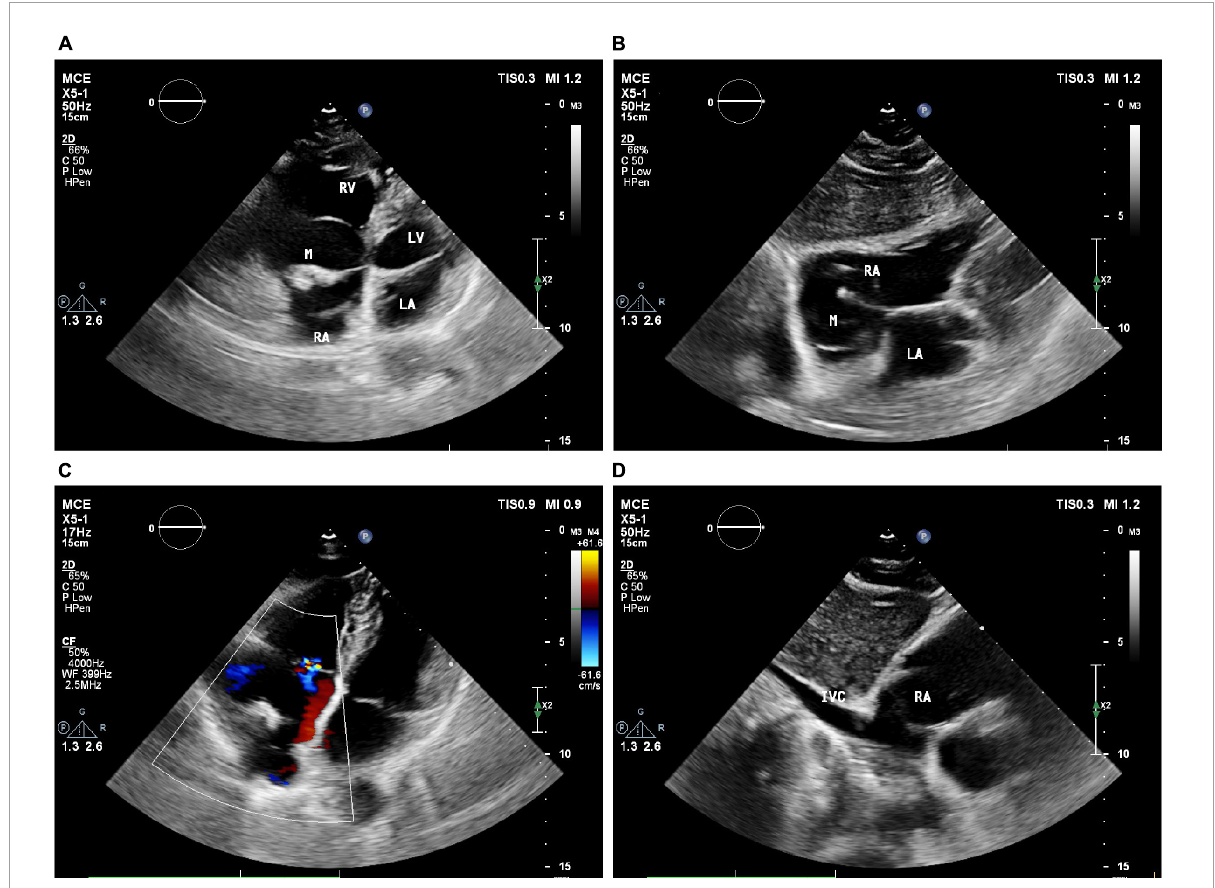
FIGURE1 Echocardiography showed a large cystic-solid mixed echogenic lesion in the right atrium. Apical four-chamberview (A) and subxiphoid four-chamber view (B) showed that the mass was attached to the right atrial surface of the atrial septum. Ultrasound findings of tricuspid valve orifice (C) andinferior vena cava (D) . M = (intracardiac